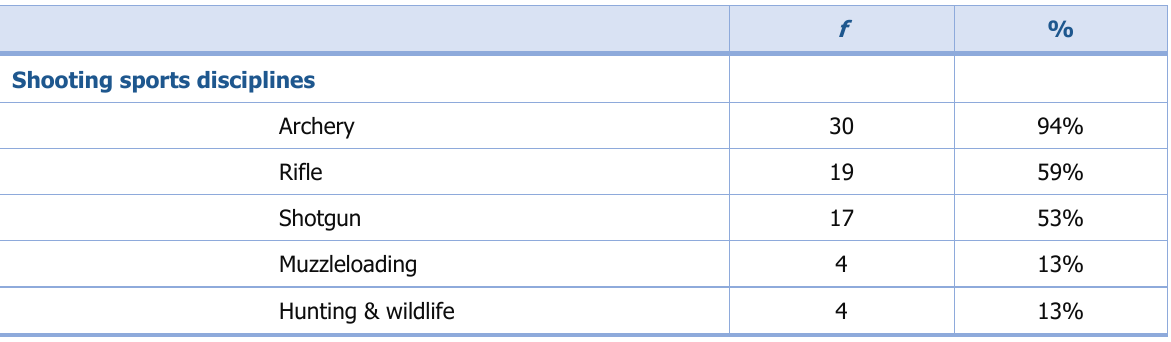
Table 2. Description of County Shooting Sports Programs (n =